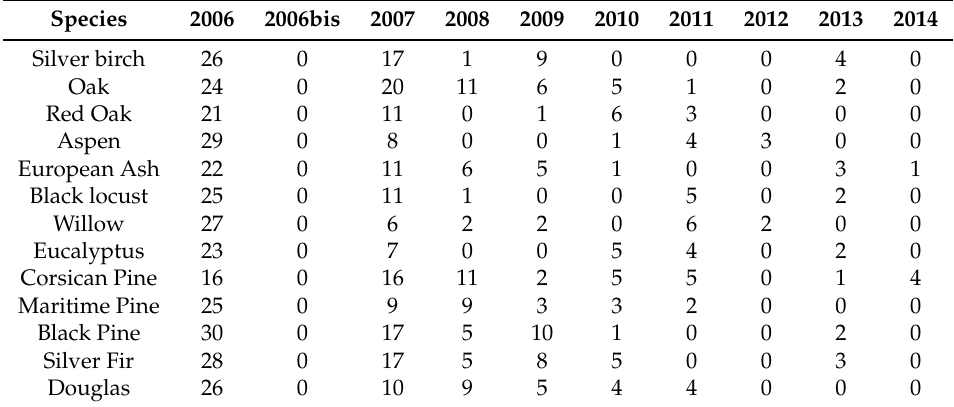
Table A3. Percent of reference pixels affected by clouds or shadows detected by the MACCS algorithm for each species and each year.